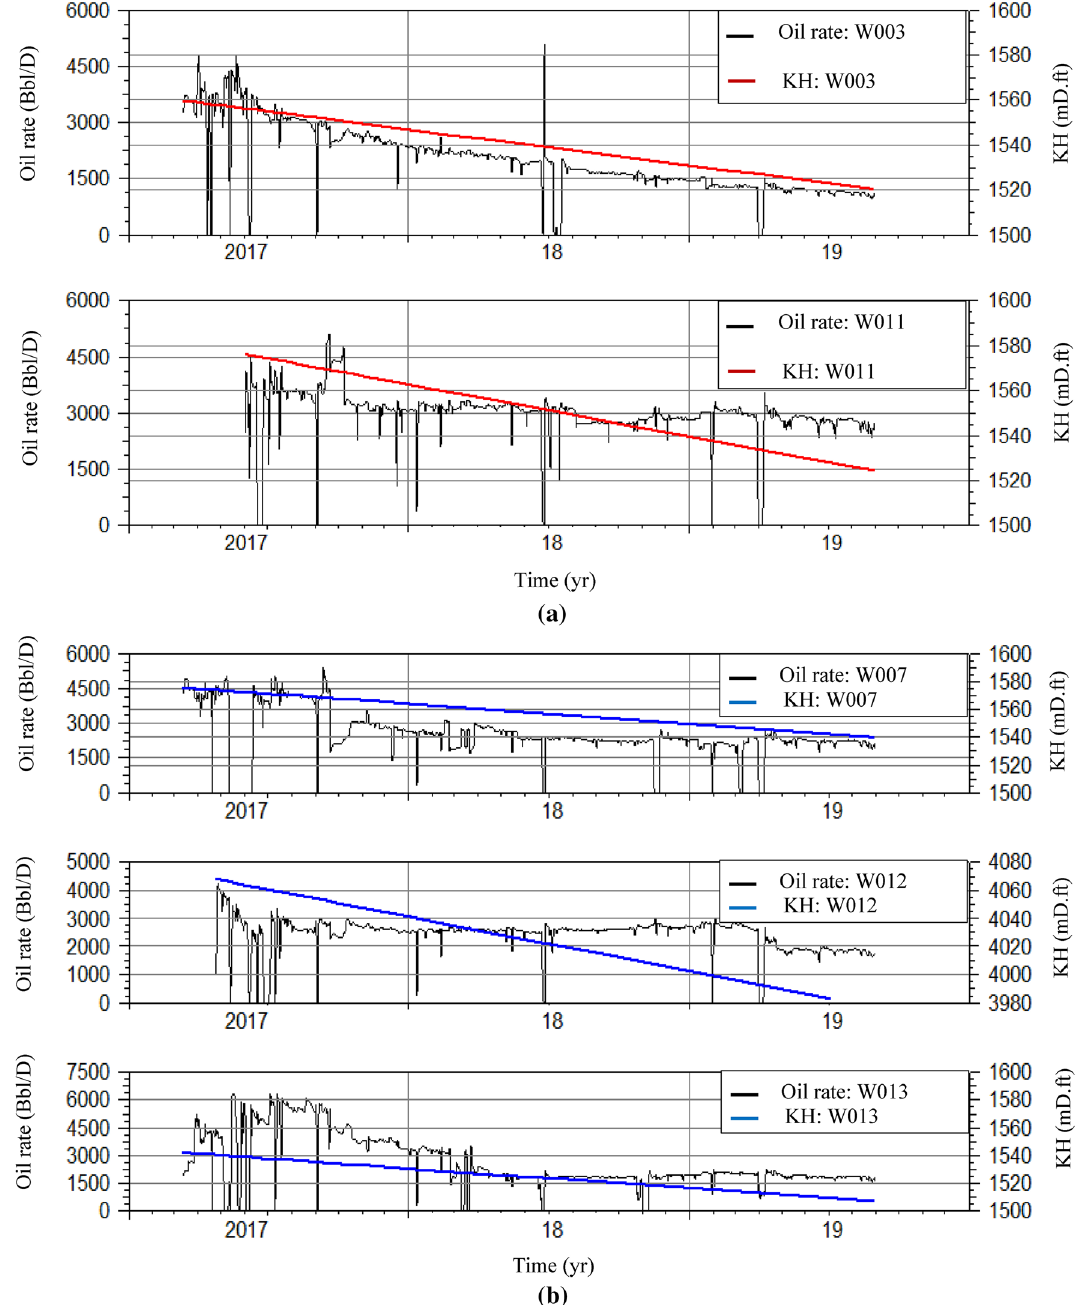
Fig. 6 kh and oil rate vs. time for a low productive wells, b wells with high water and low oil production, c high oil and water